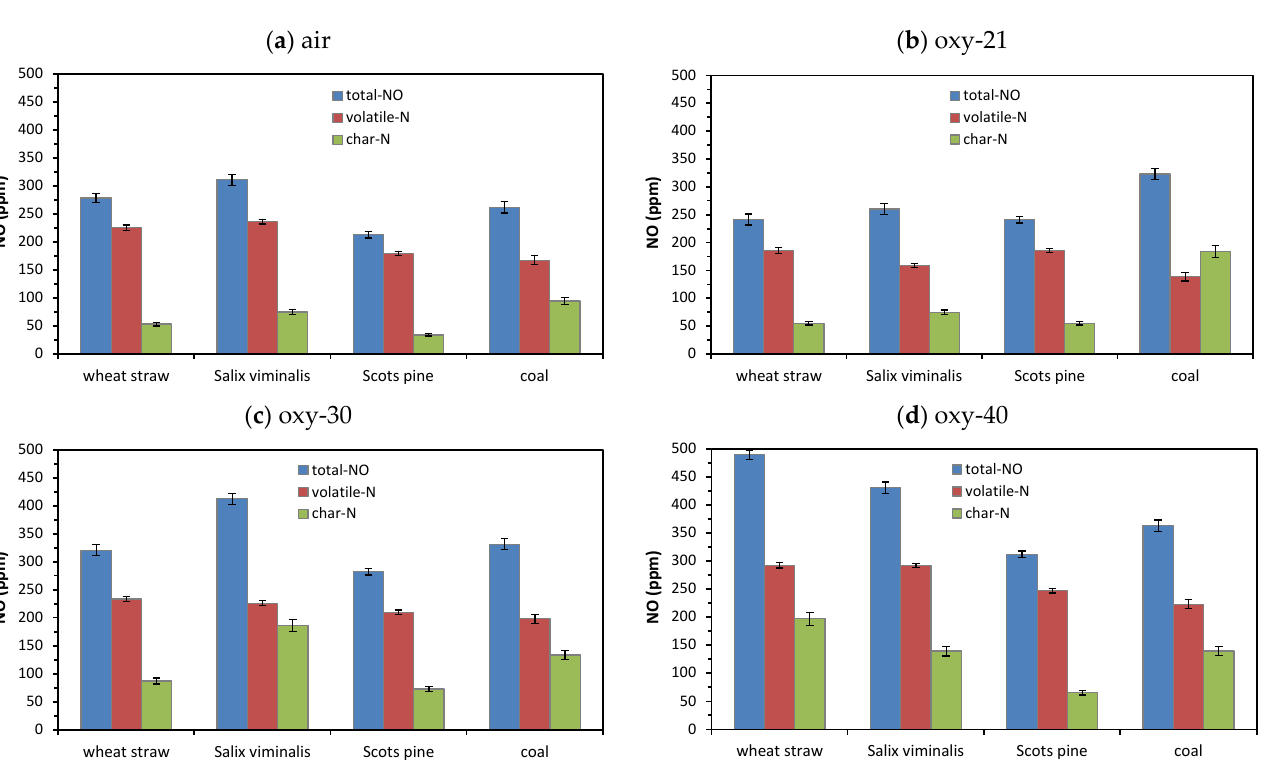
Figure 11. Effect of oxidizing atmosphere on NO emissions during combustion. Vertical bars represent standard deviation.